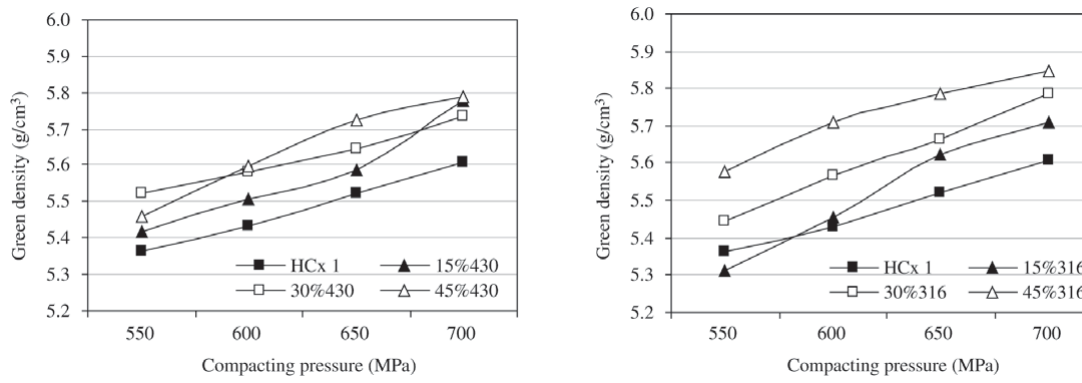
Figure 1. Compressibility curves of diluted materials.